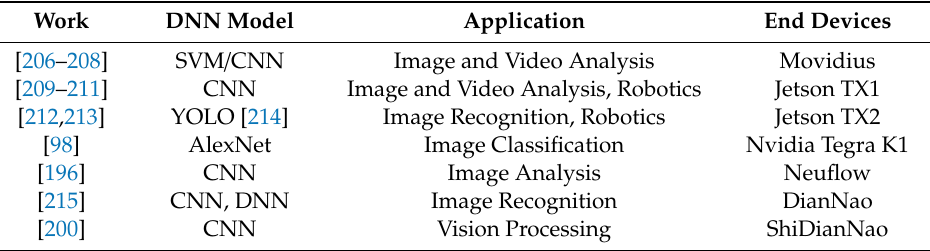
Table 3. Artificial Intelligence (AI) accelerator devices that implement edge